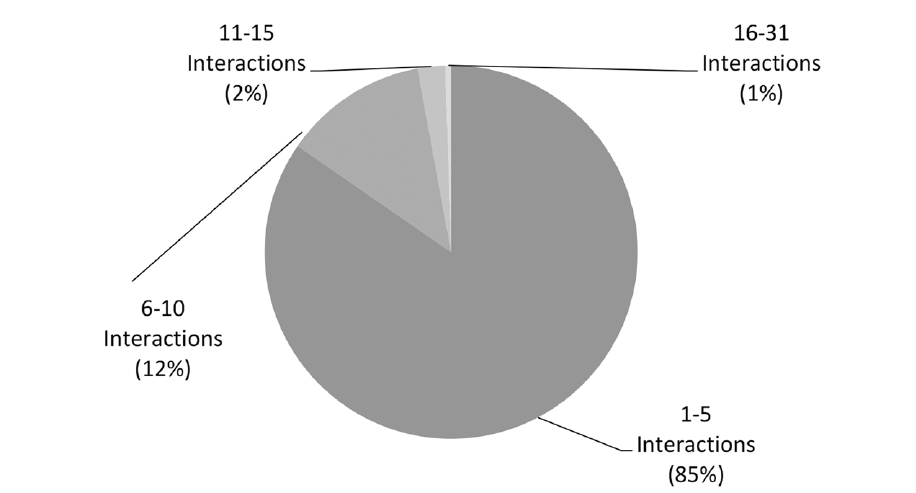
FIGURE 1 – Frequency of different number of clinically relevant Drug- Drug Interactions in prescriptions.